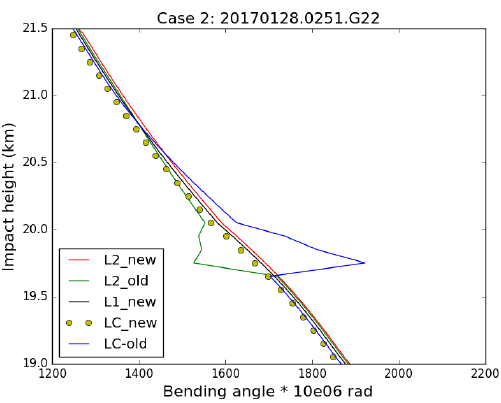
Figure 7. Good case 1 – the bending angle of L2, L1 and LC before and after correction.